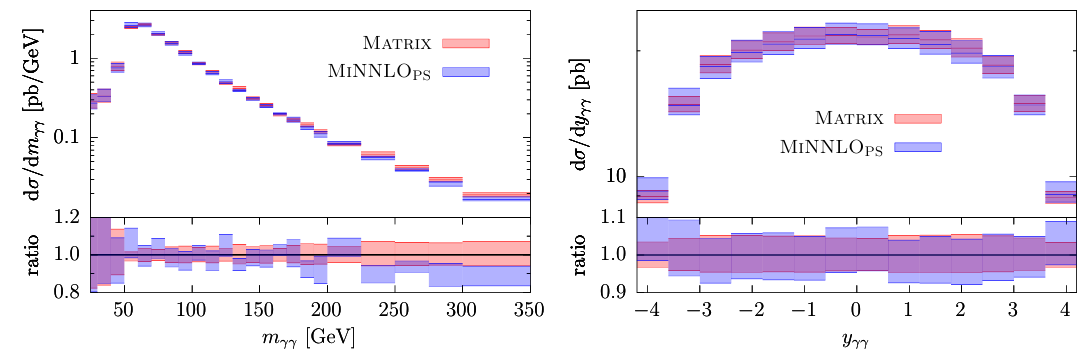
Figure 3 . Comparison between fixed-order results from Matrix and MiNNLO PS for the diphoton invariant mass and rapidity, as in figure 2. Uncertainty bands from scale variations are also shown.